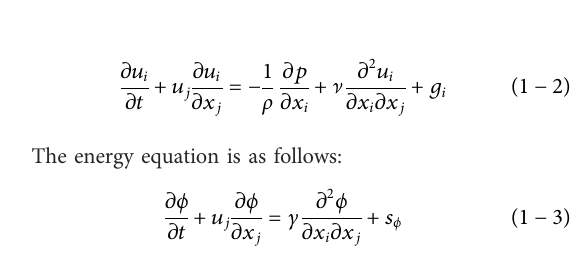
FIGURE 1 Schematic diagram of 3D model of vertical slot fi shway.